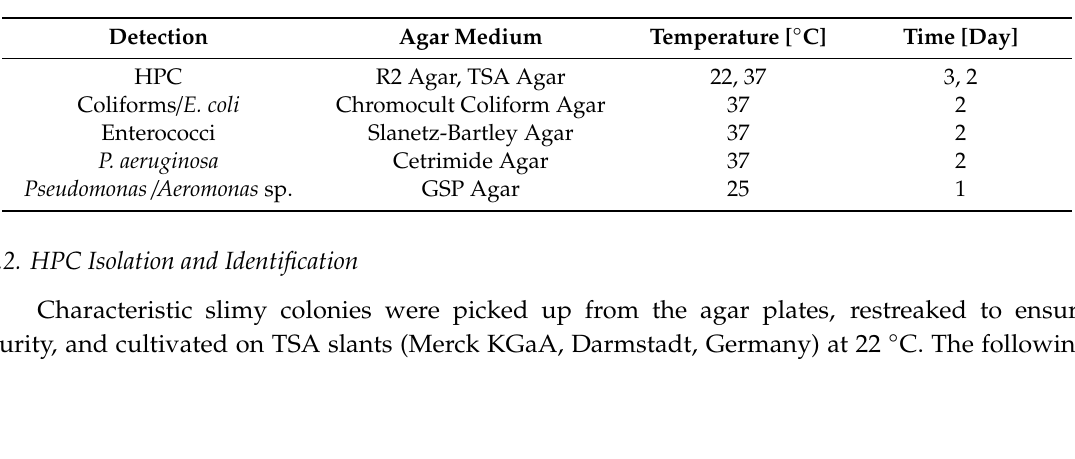
Table 2. Agar media and incubation